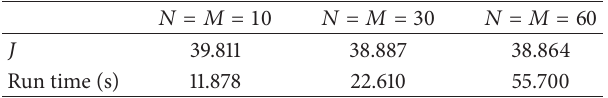
Table 5: Comparisons of optimization performances and computa- tional